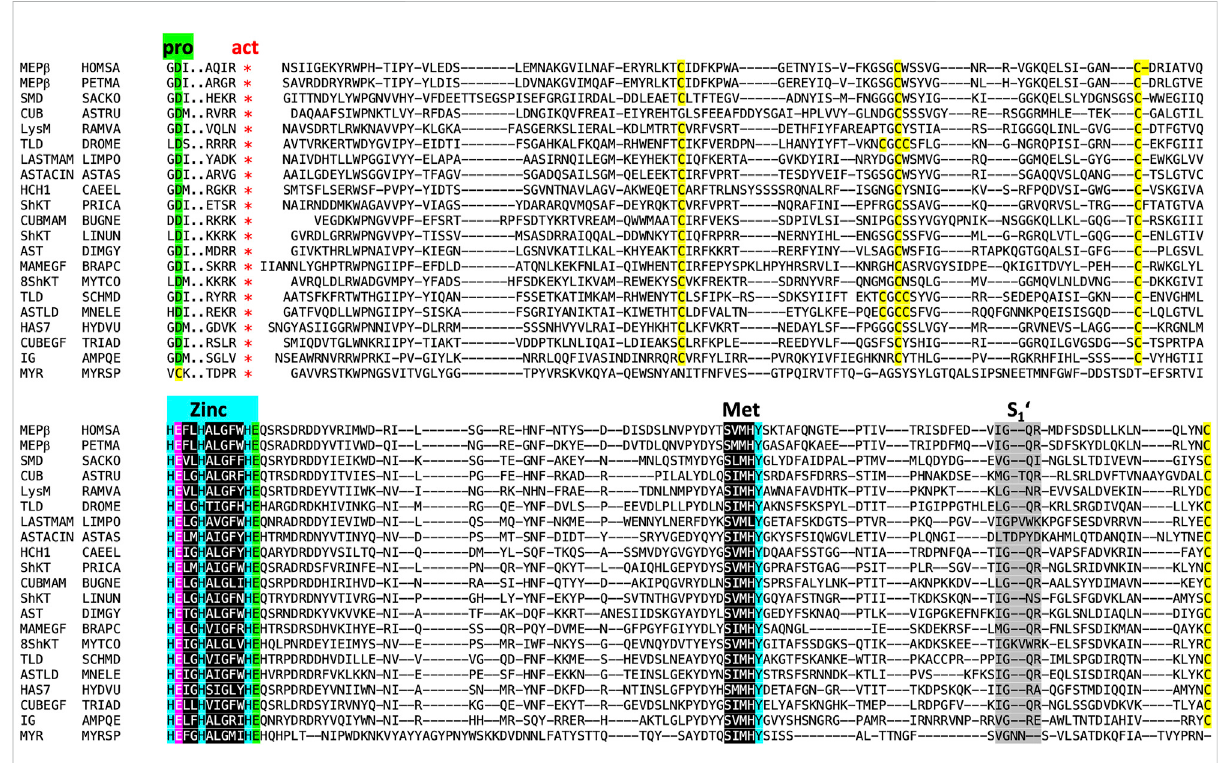
FIGURE 4 Sequence alignment of 20 astacins representing different animal phyla excerpted from the sets shown in Figure 5, Table 1 and Supplementary Table S1. In the headline, “ pro ” labels three residues of the prodomain with the conserved aspartate residue (underlaidgreen) responsible for